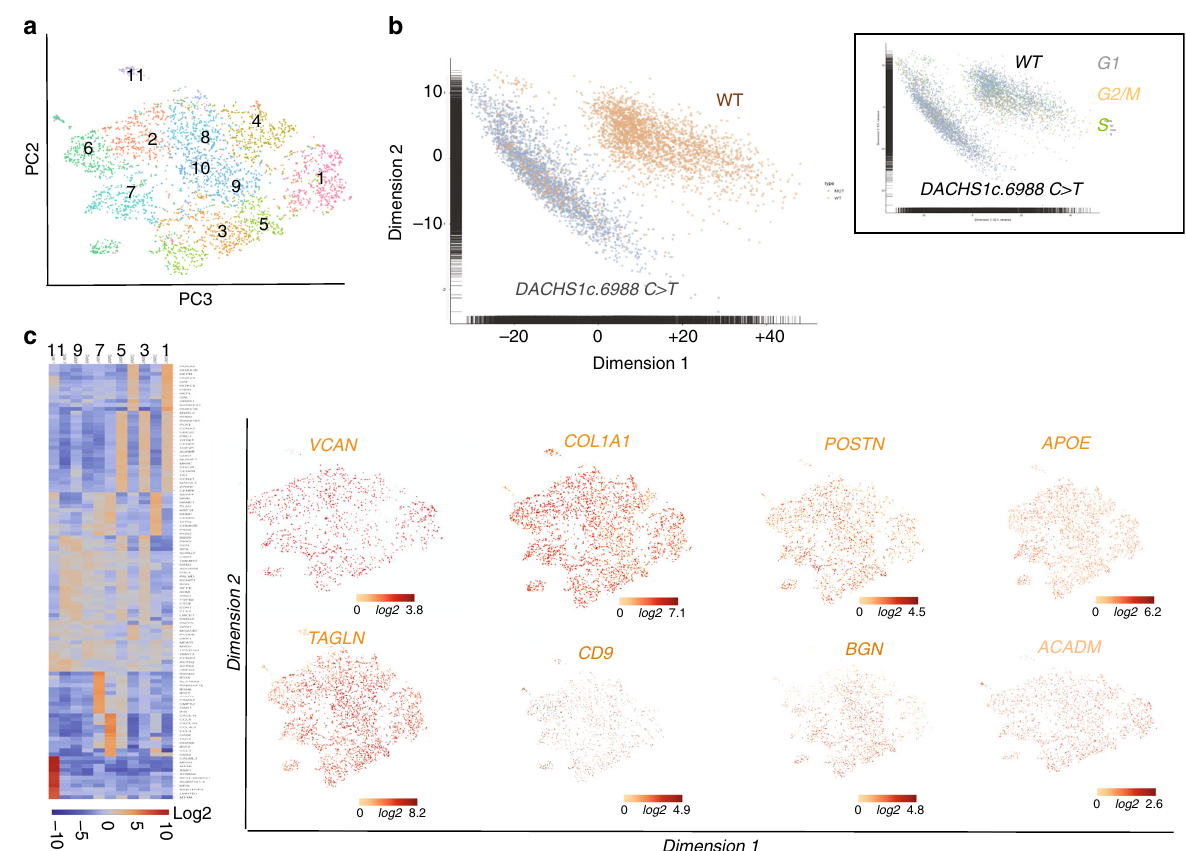
Fig. 7 Single cell-sequencing of DCHS1 c.6988 C>T post-EMT valvular interstitial cells. a t-distributed stochastic neighbor embedding (t-SNE) 2D cell map 10X genomics ( n = 4316 cells). b PCA of wt versus DCHS1 c.6988 C>T post-EMT (BMP2 treated) HPVC cells. Inset: PCA of cell cycle genes expressed in wt versus DCHS1 c.6988 C>T . c Graph-based Log2 fold changes in gene expression of cell clusters compared to all other cells (left panel) and highlight of cell populations expressing genes marking fi brosa or spongiosa valve